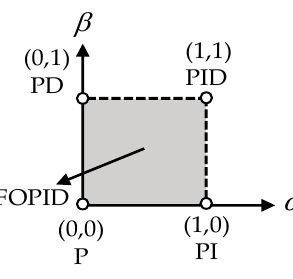
Figure 3. Comparison of the P, PI, PD, PID, and fractional order PID (FOPID) controllers.